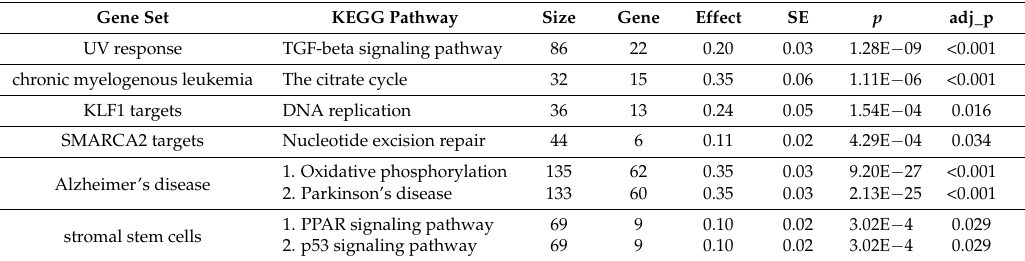
Table 4. The closest KEGG Pathway